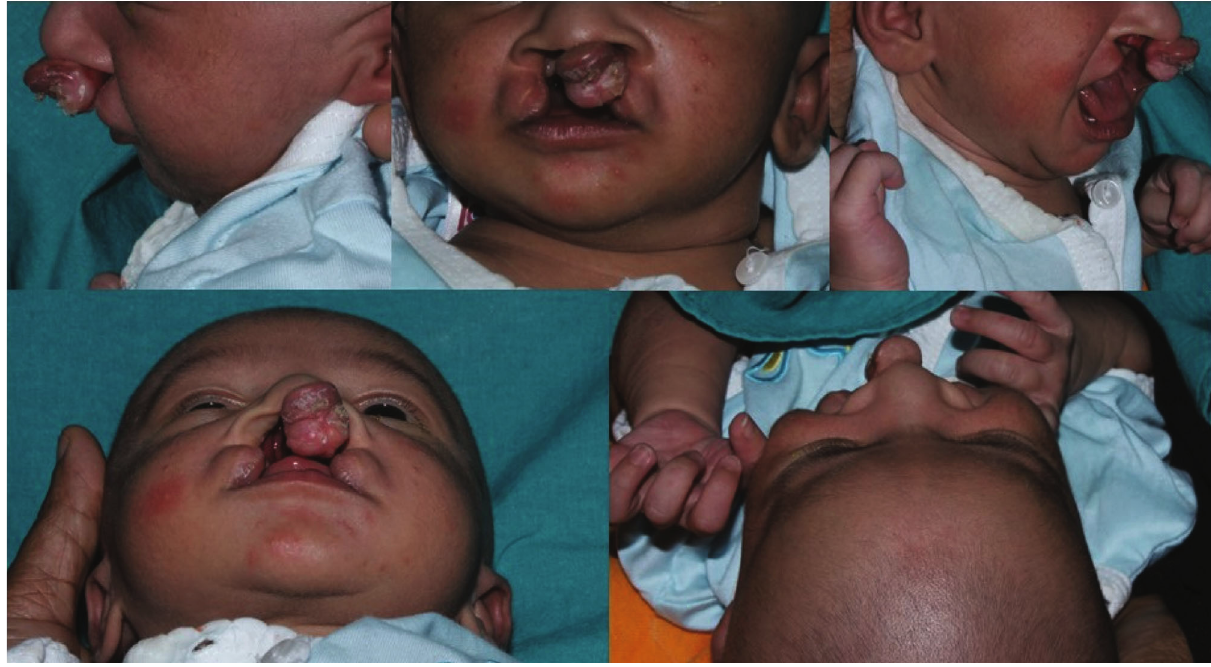
Figure 1: Pre-treatment: